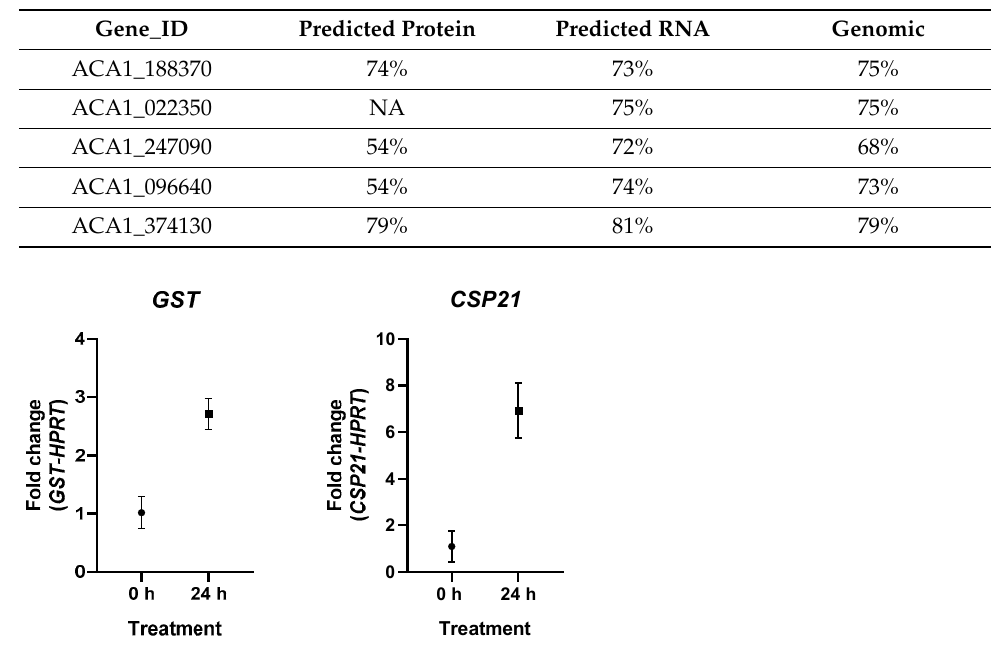
Table 3. Identity values for the five hypothetical proteins in relation to glutathione S-transferase c-terminal domain. The values obtained from the predicted protein, the predicted RNA, and the genomic sequence as obtained from AmoebaDB.